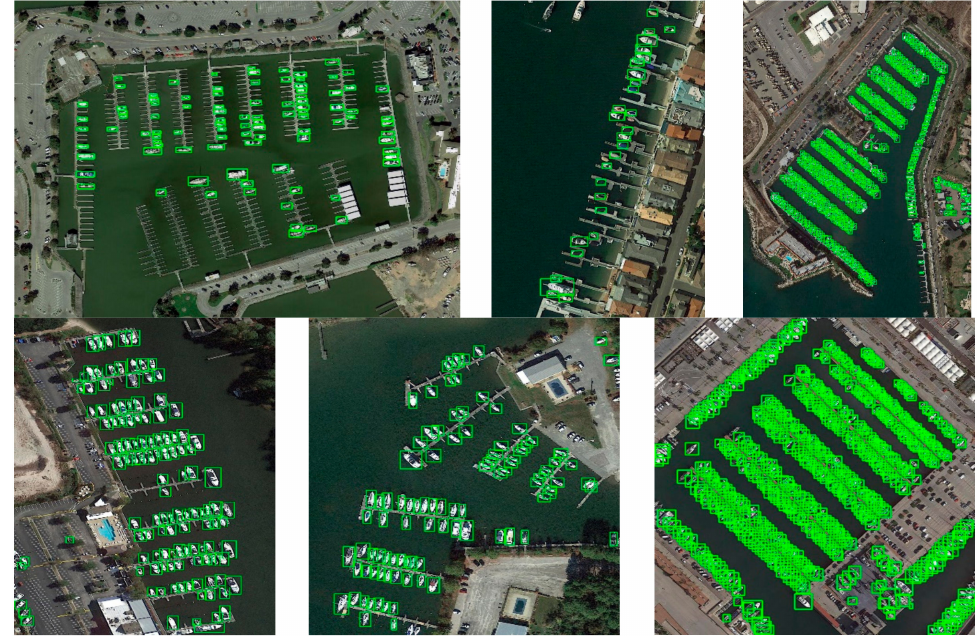
Figure 16. The labeled ship samples in DOTA, which have been scaled down.